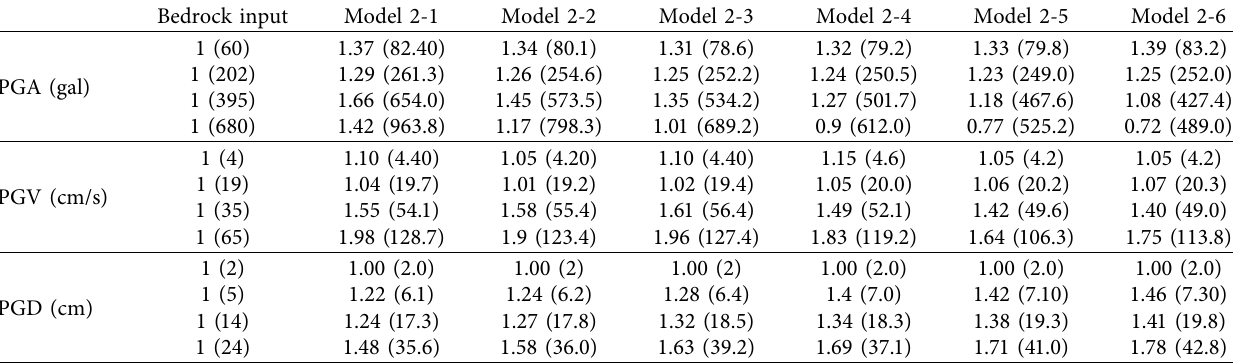
Figure 6: Spectral accelerations for the six multiple interbedded models under four seismic inputs. Table 4: Ground motion amplification ratios for the six multiple interbedded models under four seismic